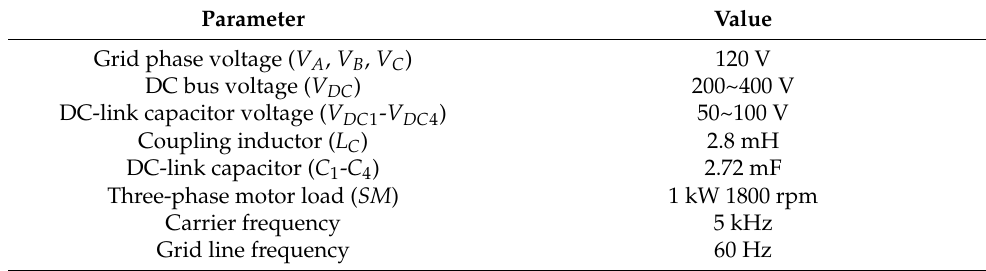
Figure 15. Experiment setup. Table 4. Parameters of the experimental system.